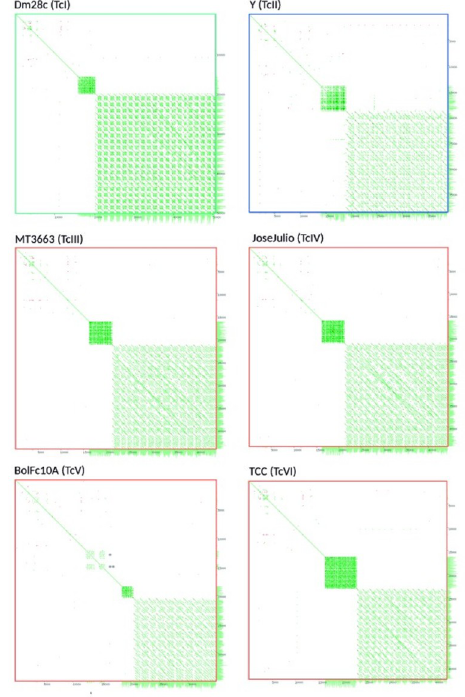
Fig 3. Dotplot of maxicircles assemblies. Dotplot visualizations by Yass [67] of self-self maxicircle of the six DTUs. Three main classes of maxicircle could be observed (green, blue and orange squares).